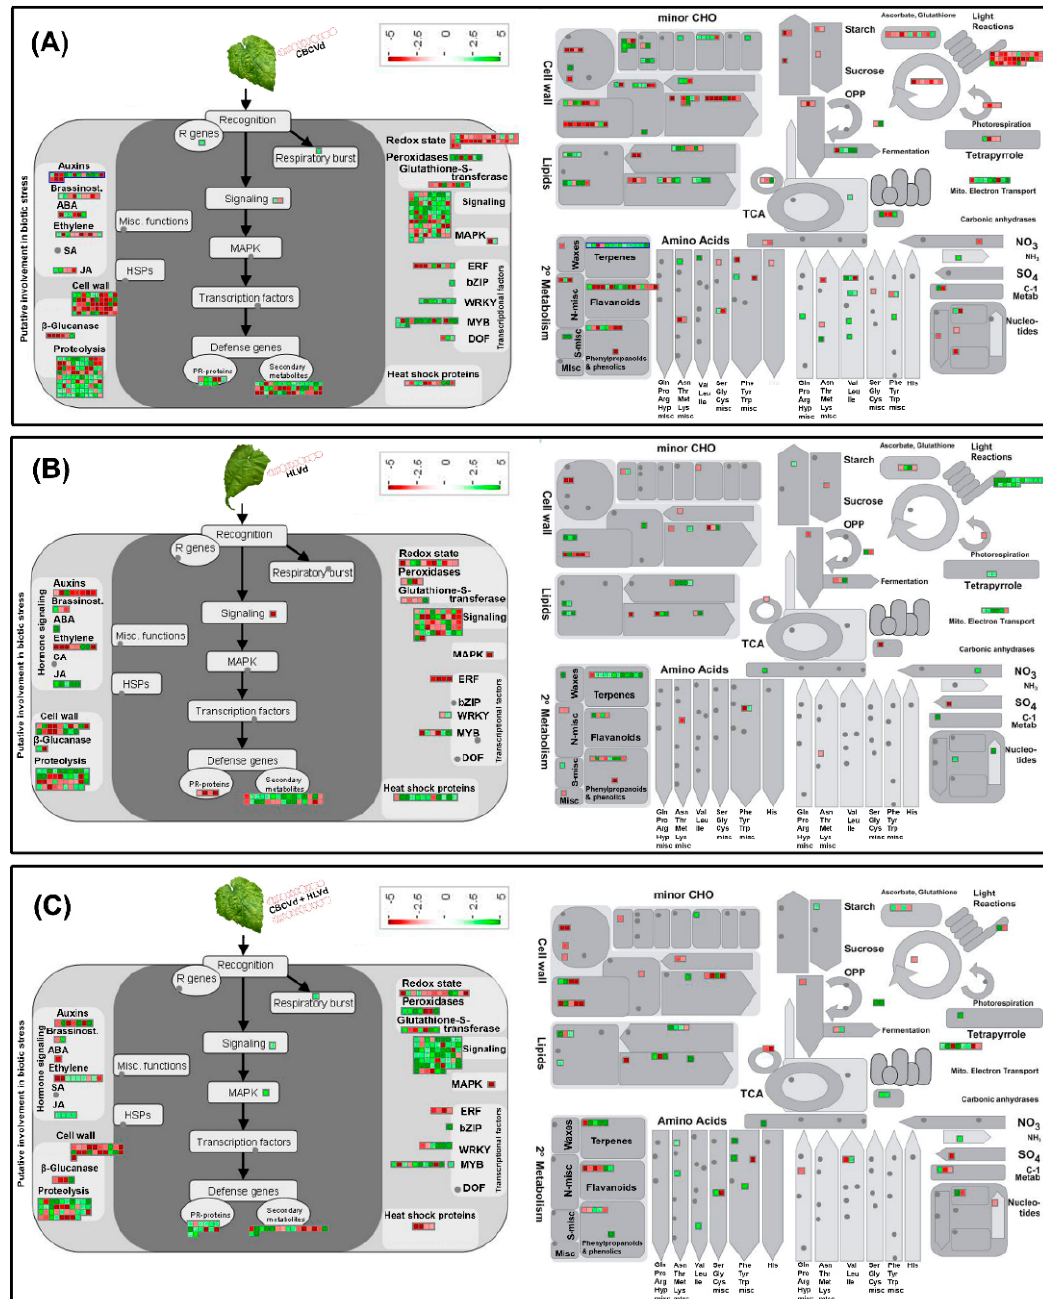
Figure 5. Overview of the MapMan visualization of differences in transcript levels in CBCVd infected ( A ), HLVd infected ( B ), and HLVd-CBCVd coinfected ( C ) hop. The log 2 fold changes of significantly differentially expressed genes were imported and visualized in MapMan. Red and green displayed signals represent a decrease and an increase in transcript abundance, respectively in single CBCVd, HLVd infected and single CBCVd, HLVd infected, and HLVd-CBCVd coinfected relative to the mock-inoculated samples of hop. The scale used for coloration of the signals (log 2 ratios) is presented.